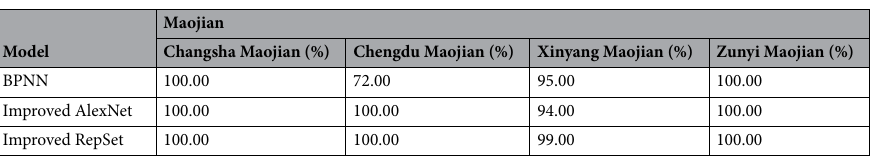
Table 3. Classification precision of different models for different geostrophic Maojian.